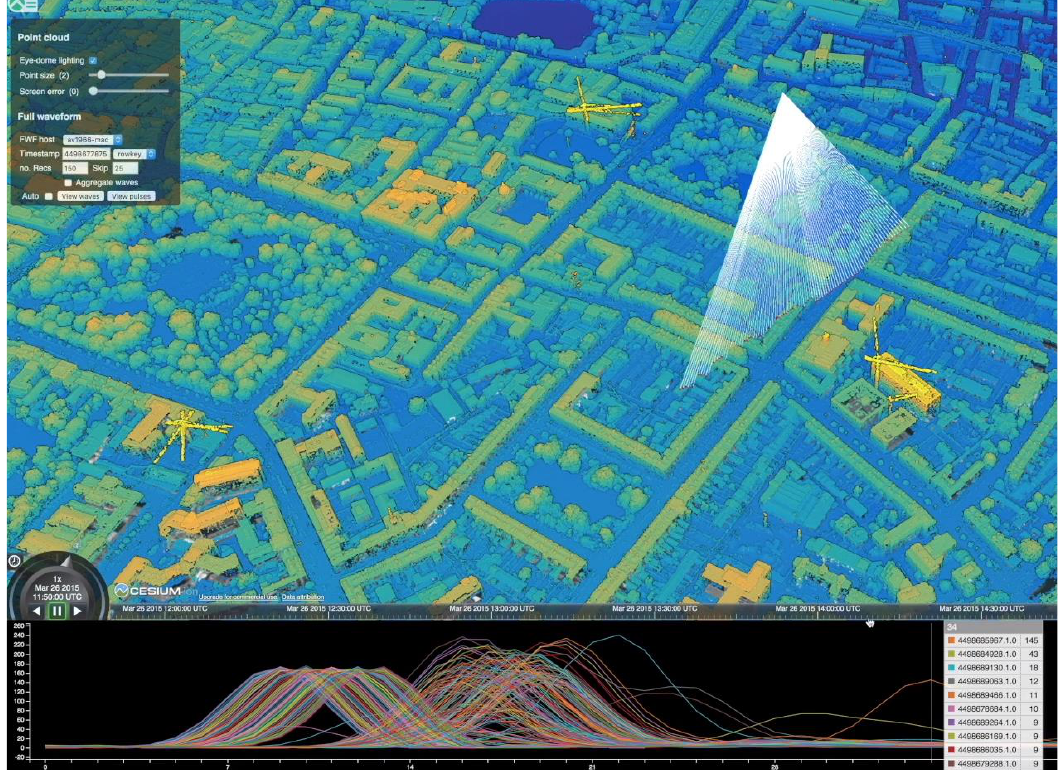
Figure 2. Three-dimensional web application for